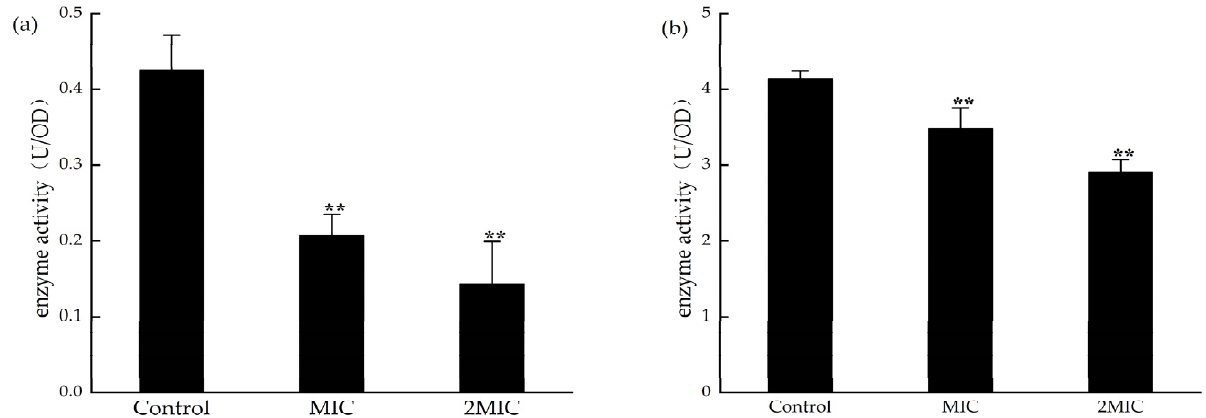
Figure 10. ( a ) Effect of MA on S. aureus SDH and ( b ) MDH; **: Compared with the control group, the difference is extremely significant ( p < 0.01).